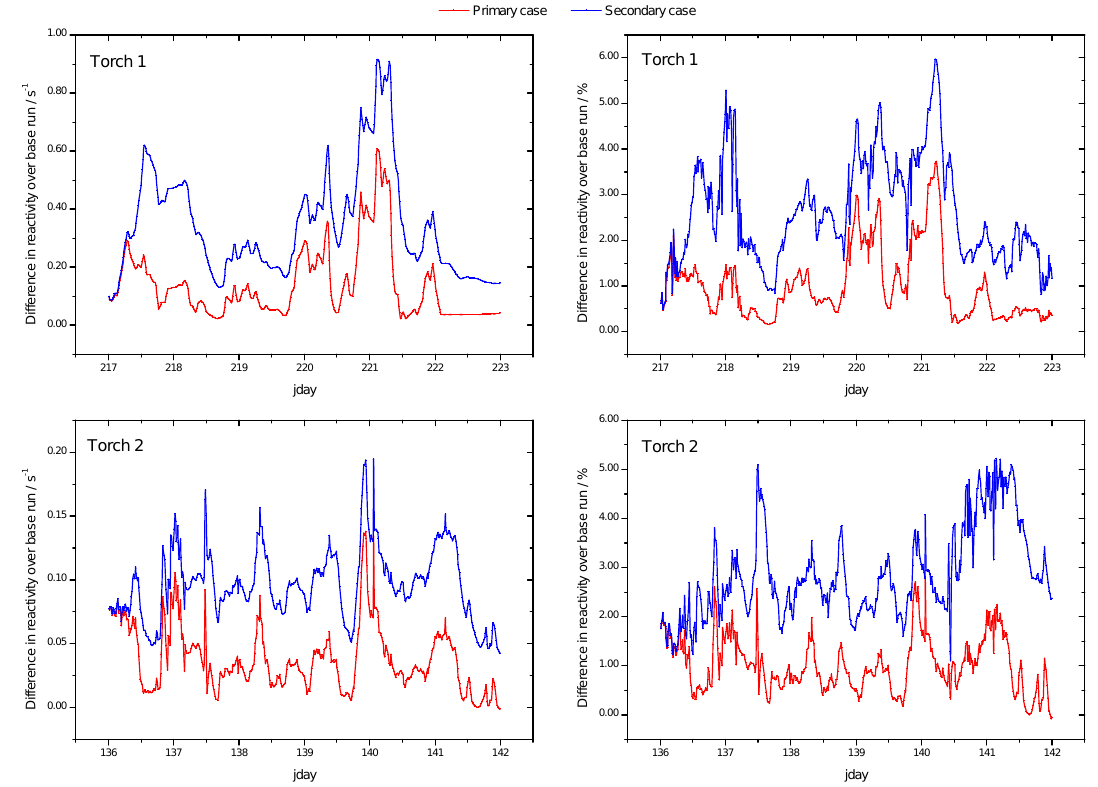
Figure 9. Modified model data for the TORCH 1 and 2 campaigns. Plots show a difference in reactivity over the original model base case whereby VOC aromatic reactivity has been supplemented using the proportionality factor determined in Figure 6. The red trace shows the difference between the base case and the primary case, which has the additional aromatic content represented by an additional species with the same reactivity as toluene, but after initial reaction it does not yield further oxidation products. The blue trace shows the difference between the base case and the secondary case where the toluene mixing ratio has been increased to account for the additional aromatic reactivity and secondary reactions are included. Jday = Julian day